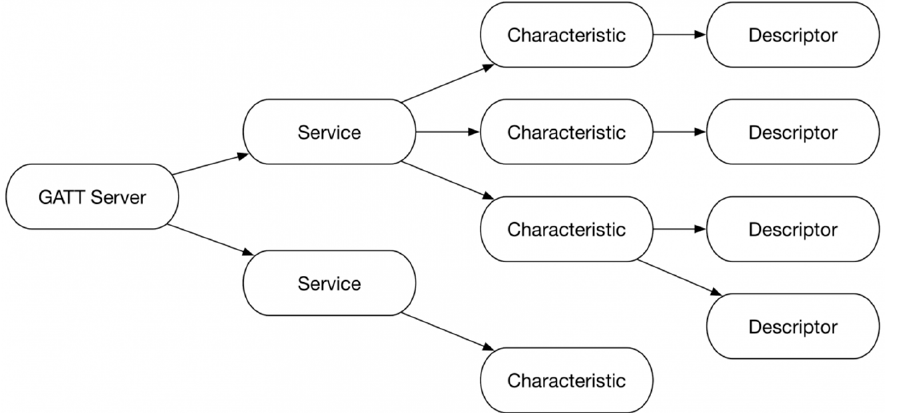
Figure A2. Leveled View of a Gatt Server Configuration [42].